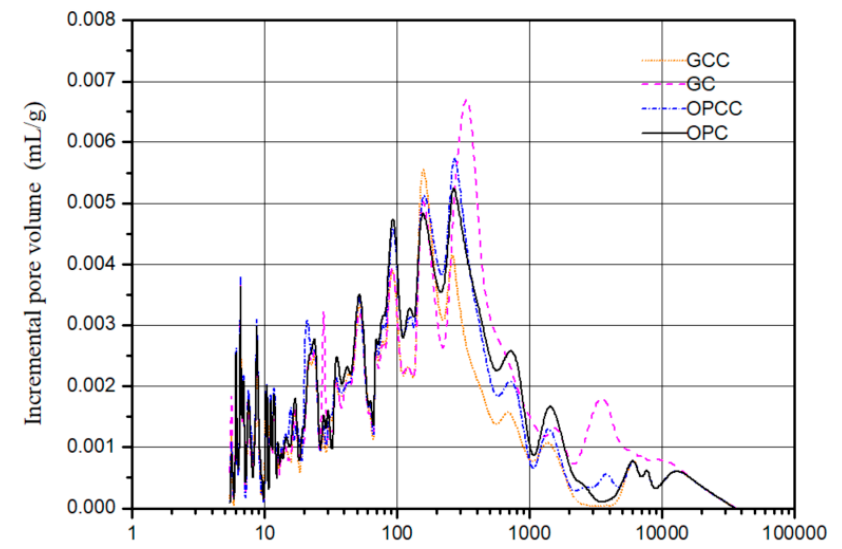
Materials 2021 , 14 , 832 14 of 19 Figure 12. Cumulative volume diagram of capillary and colloidal pores. Figure 12. Cumulative volume diagram of capillary and colloidal pores.